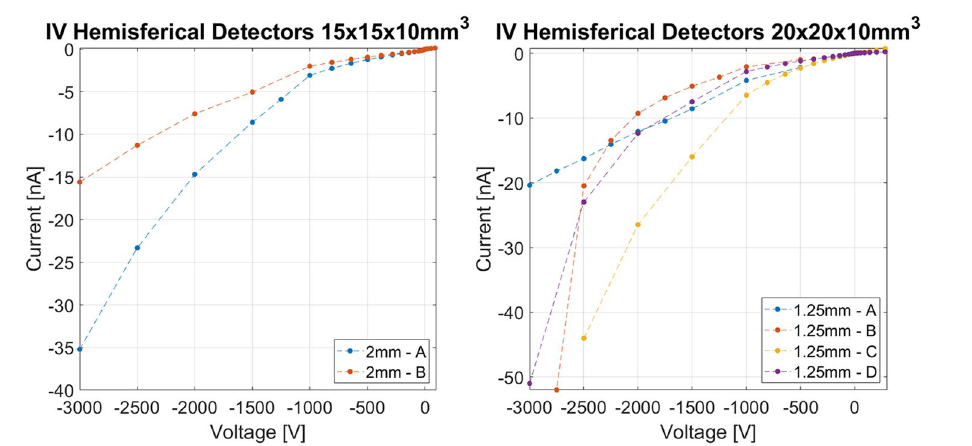
Figure 11. Current–voltage curves for the 15 × 15 × 10 mm 3 hemispherical detectors (left) and for the 20 × 20 × 10 mm 3 ones (right). Measurements were carried out at 20